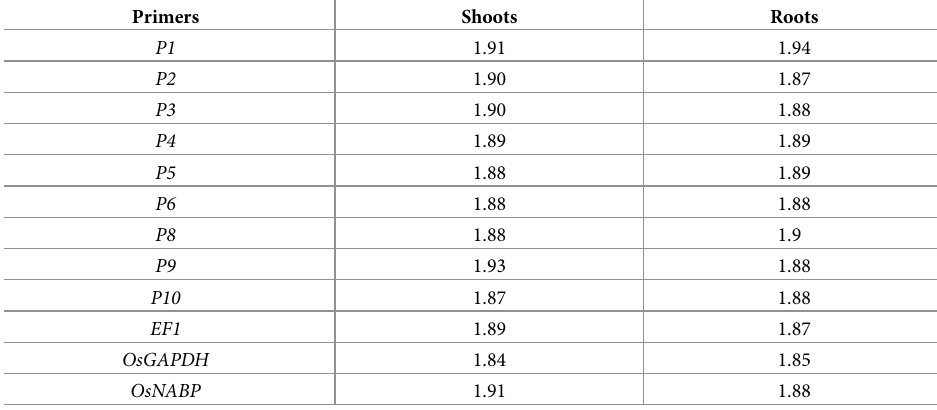
Table 2. Efficiency of primer pairs used for RT-qPCR amplification in each